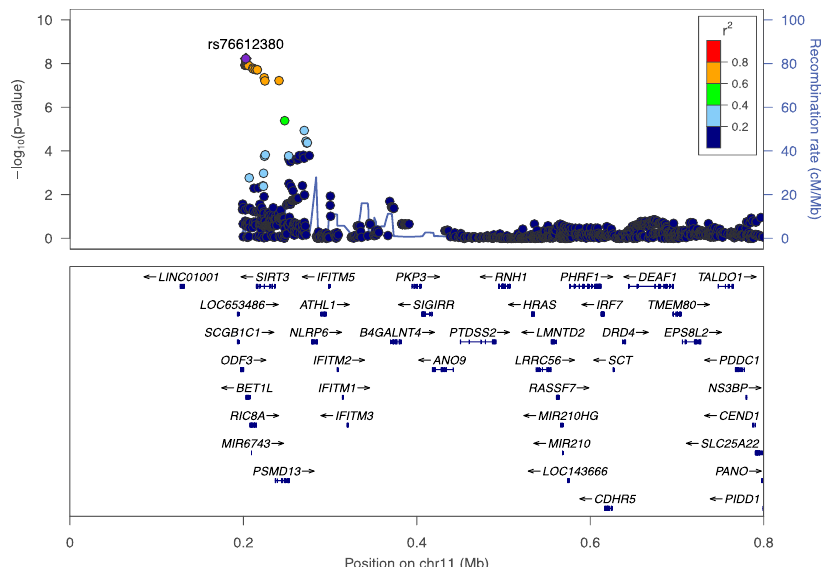
Fig. 2 Regional association plot of BET1L region. Associations of the BET1L region by LocusZoom software (v. 1.3). Colored according to the linkage disequilibrium with the lead variant (rs76612380).